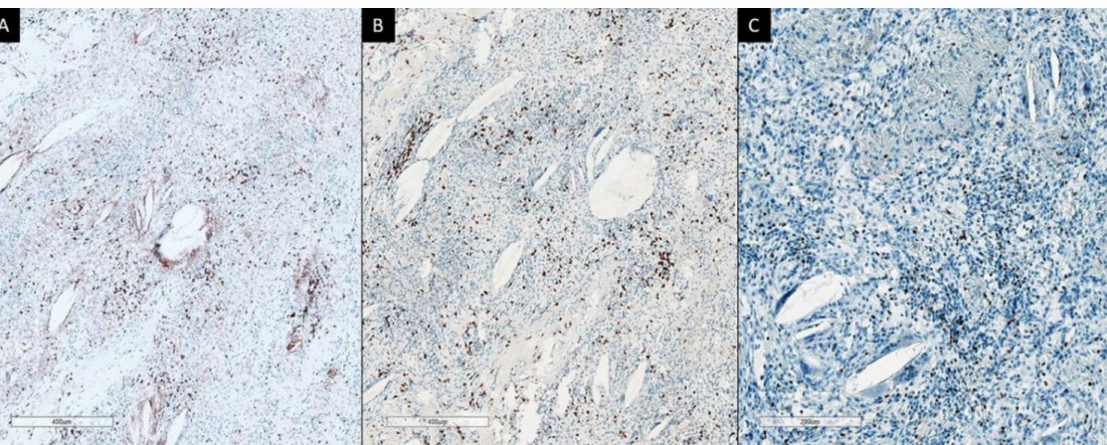
Figure 2. Immunohistochemistry: Histologic presentation of CD4+ ( A ) and CD8+ T-lymphocytes ( B ) in the area adjacent to necrosis of the patient with lung cancer treated with SBRT-PATHY with complete histological response, where slight predominance of later is obvious. FoxP3 positive cells and small cluster are also present ( C